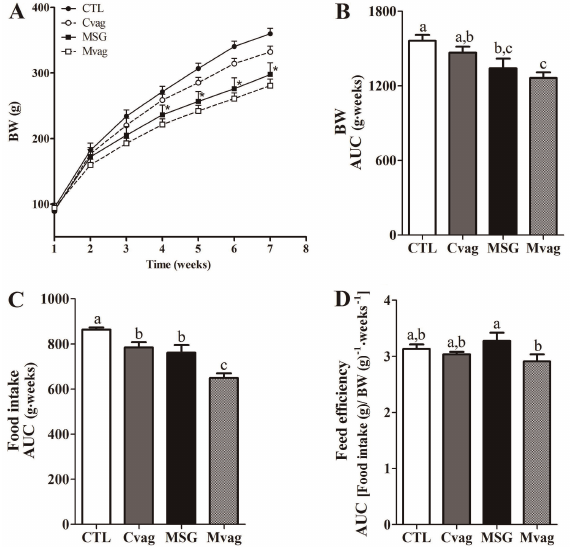
Figure 1. Body weight ( A ) of CTL, Cvag, MSG and Mvag rats recorded over 6 weeks (n=6). Means±SE of the total BW ( B ) reported as the area under growth curve (AUC), food consumption ( C ) and food efficiency ( D ). BW: body weight; CTL: control; Cvag: CTL with subdiaphragmatic vagotomy; MSG: monosodium gluta- mate; Mvag: MSG with subdiaphragmatic vagotomy. *MSG and Mvag were significantly different from controls. Different letters indicate statistically significant differences (two-way ANOVA fol- lowed by Duncan’s post-test, P #